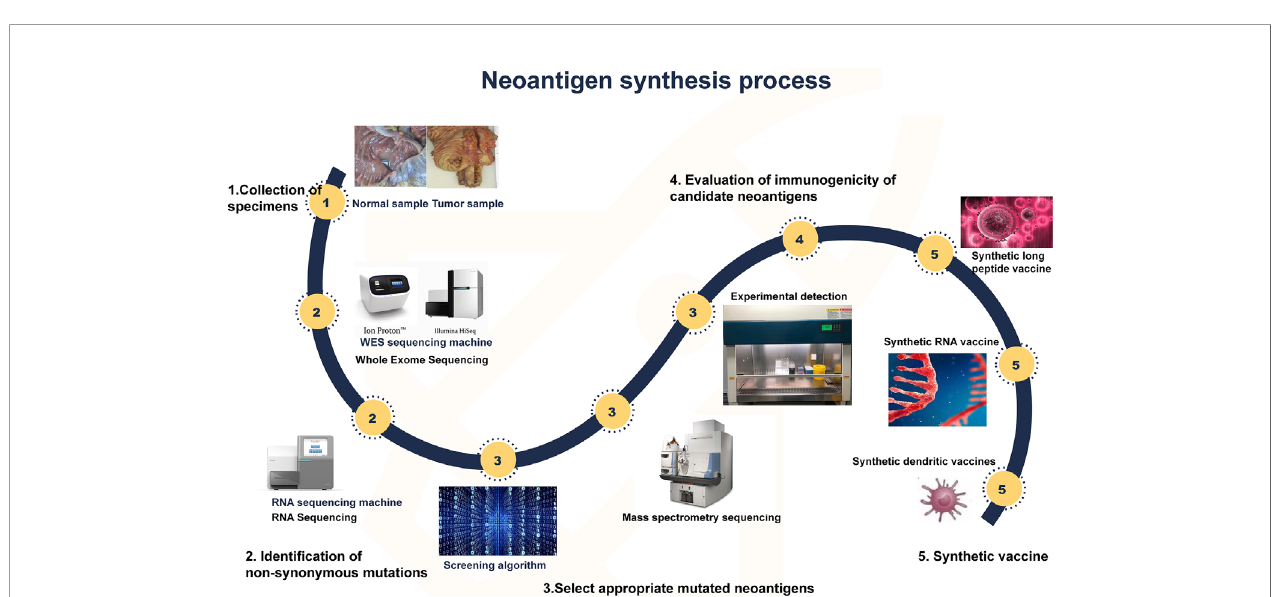
FIGURE 3 | Identi fi cation of neoantigens. First, the new antigens were found by high-throughput sequencing, then screened by algorithm and mass spectrometry, and fi nally veri fi ed by